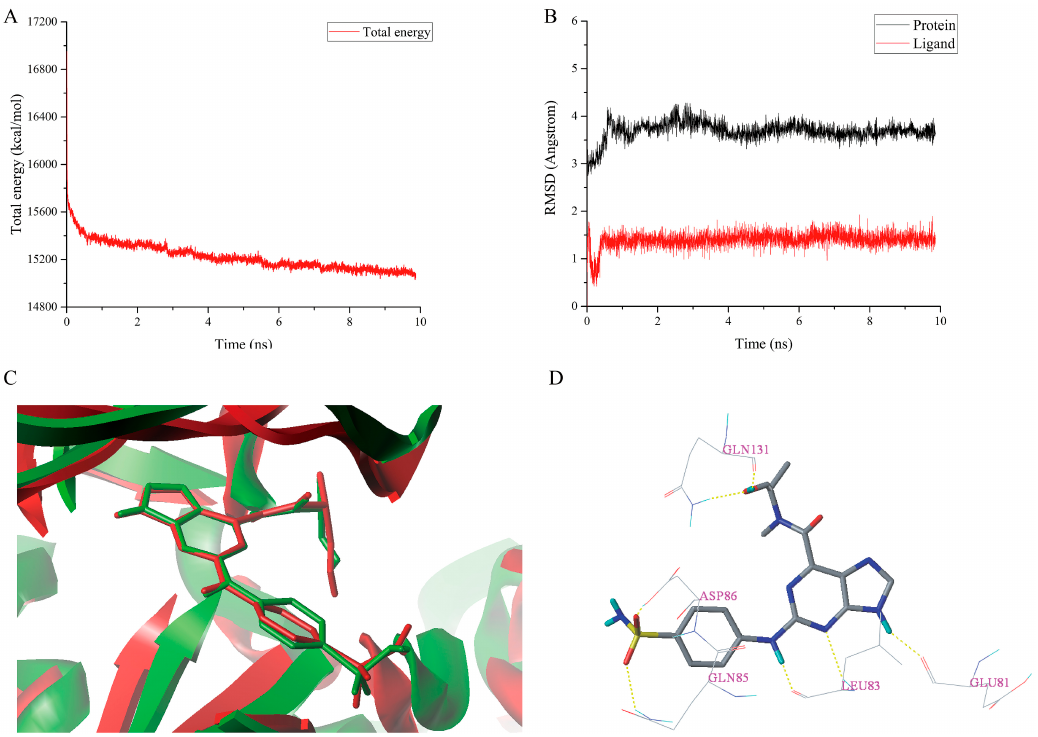
Figure 8. MD simulations result of the complex 1H1S-I60 . ( A ) The total energy plot. ( B ) The RMSDs plot. ( C ) The superimposition of the initial docked structure (red) of complex 1H1S-I60 and the average structure (green) of MD simulation of complex 1H1S-I60 . ( D ) The conformation of I60 after MD simulations. Hydrogen bonds were shown as yellow dashed lines and non-polar hydrogens were removed for clarity.